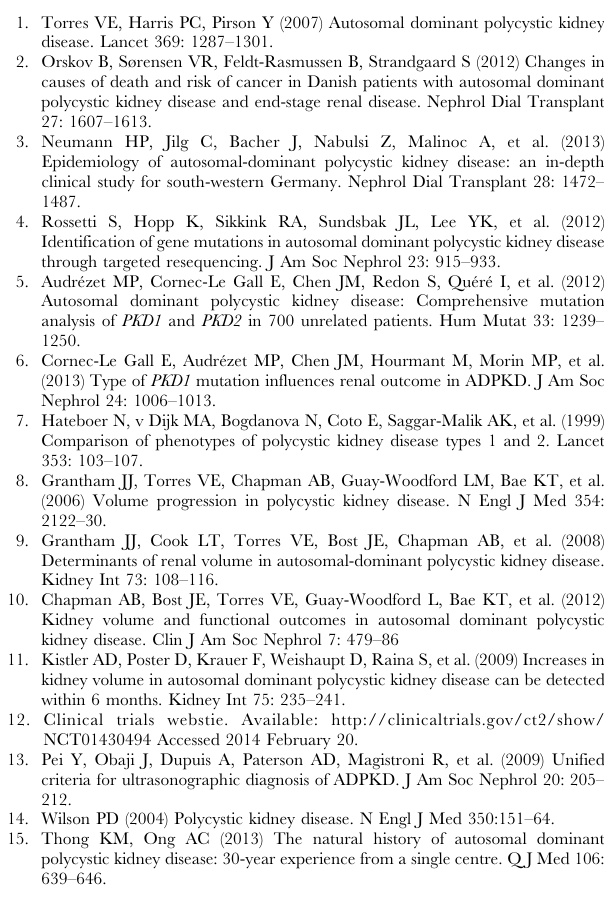
File S1 Supporting Tables. Table S1: Table shows the eGFR and the yearly changes of the eGFR, stratified by age categories. The eGFR was calculated according to the CKD-EPI formula in adults and according to the Schwarz formula in children. Table S2: Data show mean 6 standard deviation. Table S3: Table reports baseline kidney volumes in cm3. RKV, right kidney volume; LKV, left kidney volume; TKV, total kidney volume. Table S4: Table reports baseline cyst volumes in cm3. RCV, right cyst volume; LCV, left cyst volume; TCV, total cyst